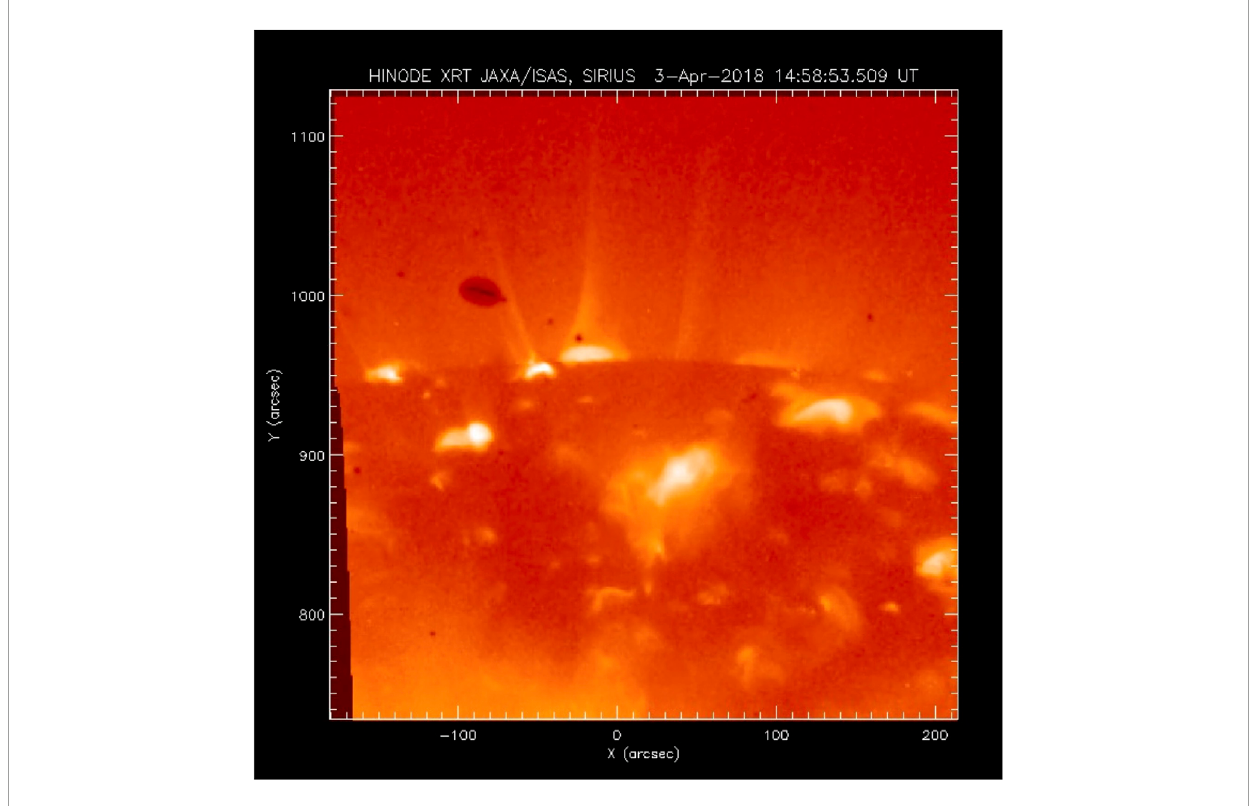
FIGURE 6 Hinode /XRT image in SXRs (from Sterling and Moore, 2023) of the northern polar coronal hole region, showing several coronal jets. The field of view (FOV) here is 6 ′ . 67 × 6 ′ . 67. This is a little larger than the minimum FOV ( 6 ′ . 0 × 6 ′ . 0 ) that would be desired for the suggested SEIM mission. (The dark oval near (−100, 1,000) and similar smaller dark spots are imaging